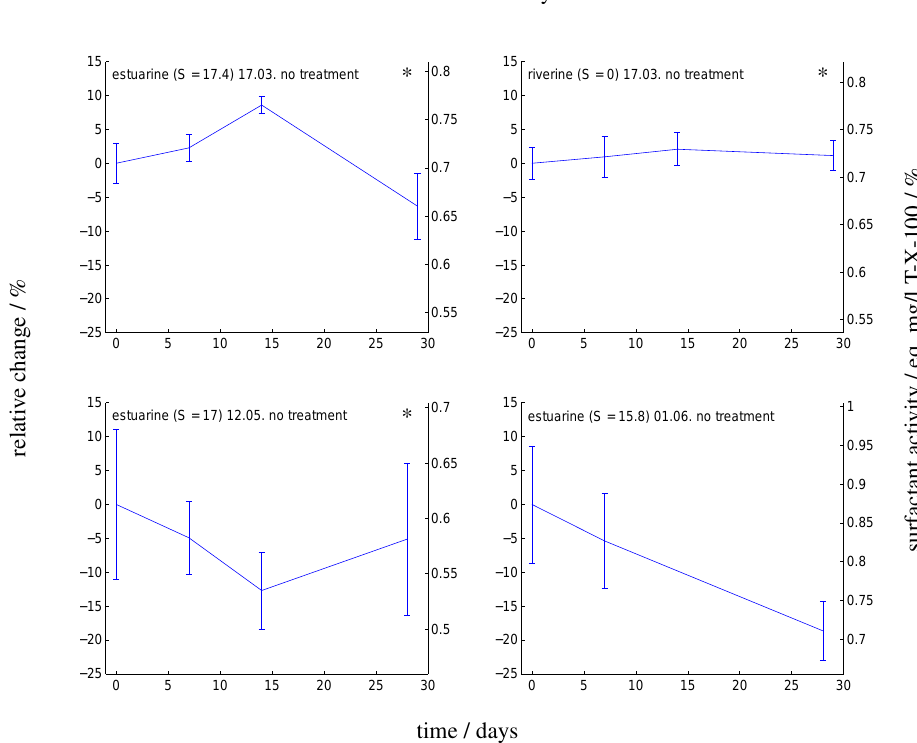
Fig. 5. SA vs. storage time for untreated SML samples collected from the Tyne estuary at two different locations (estuarine and riverine, sampling days and salinities S are stated in the plots) and on different days. Note that the left axis shows relative change, while the right axis shows absolute values. Data compatible with no change over time is marked with a star.